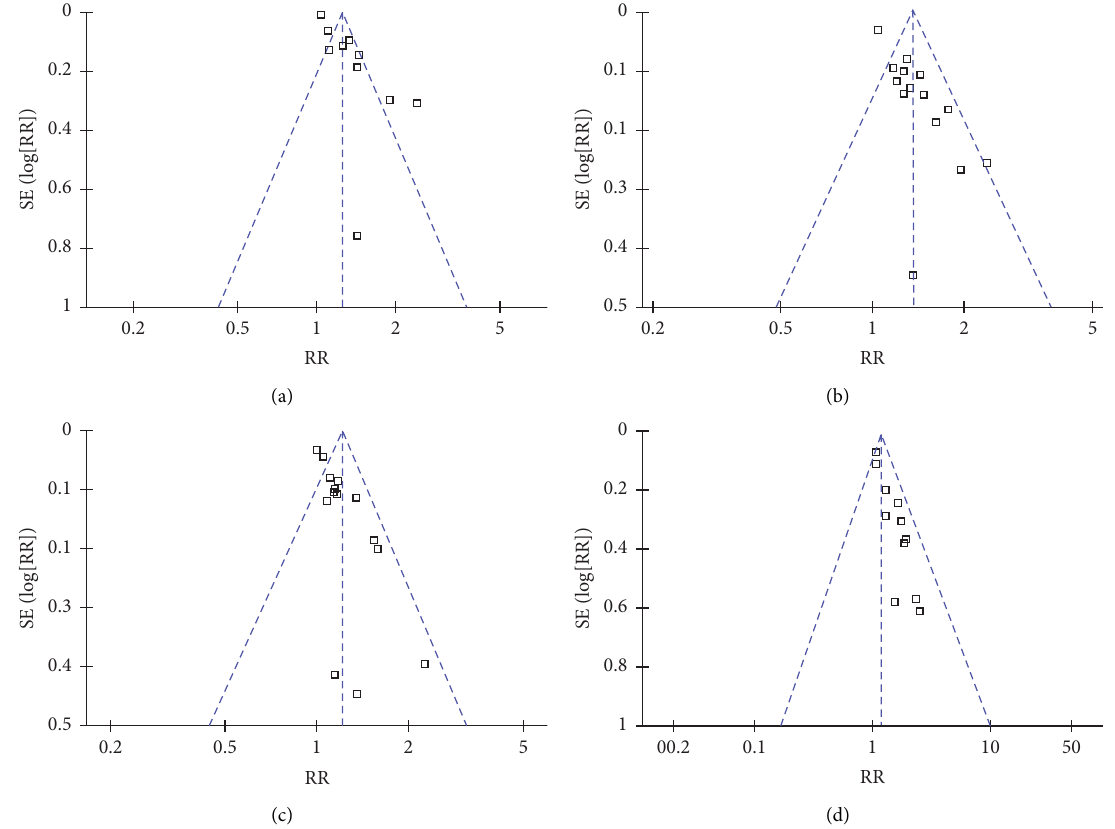
Figure 7: Funnel plots for the publication biases underlying the meta-analyses; (a), funnel plots for the meta-analysis of the efect of rhuIL-2 on the proportion of patients with sputum culture conversion to negative; (b), funnel plots for the meta-analysis of the efect of rhuIL-2 on the proportion of patients with sputum smear conversion to negative; (c), funnel plots for the meta-analysis of the efect of rhuIL-2 on the proportion of patients with radiographic focus absorption; and (d), funnel plots for the meta-analysis of the efect of rhuIL-2 on the proportion of patients with radiographic cavity